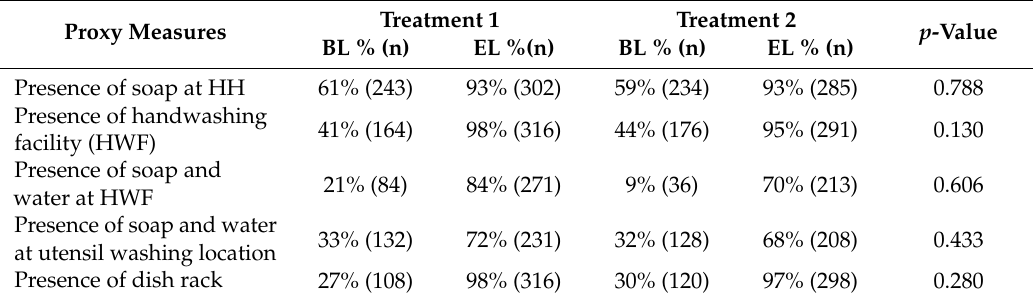
Table 3. Proxy measures compared between Treatment 1 and Treatment 2 at baseline (2017) and end line